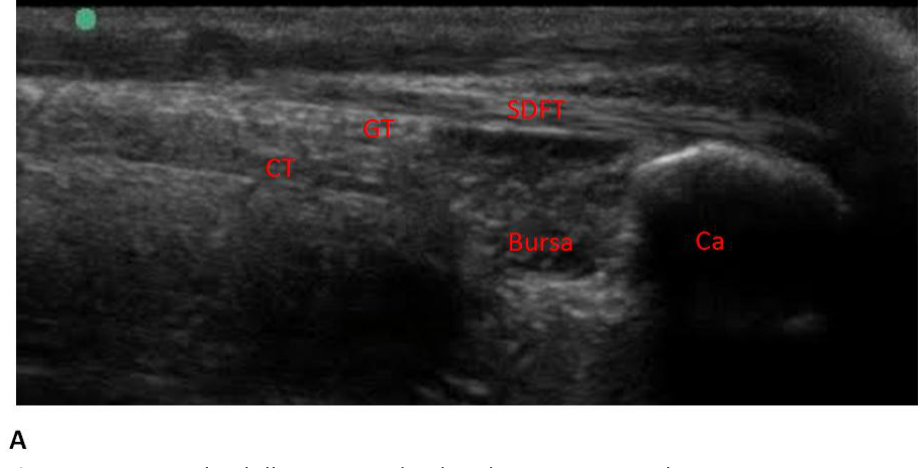
Figure 6A : Normal Achilles Longitudinal and Cross-Sectional Views Longitudinal view of a normal Achilles tendon In longitudinal images of the distal part of the tendon the gastrocnemius tendon (GT) lies between the superficial digital flexor tendon (SDFT) and the common tendon (CT). The insertional bursa (Bursa) of the common tendon is visible at proximity of the calcaneal tuberosity (Ca) and its acoustic shadowing.